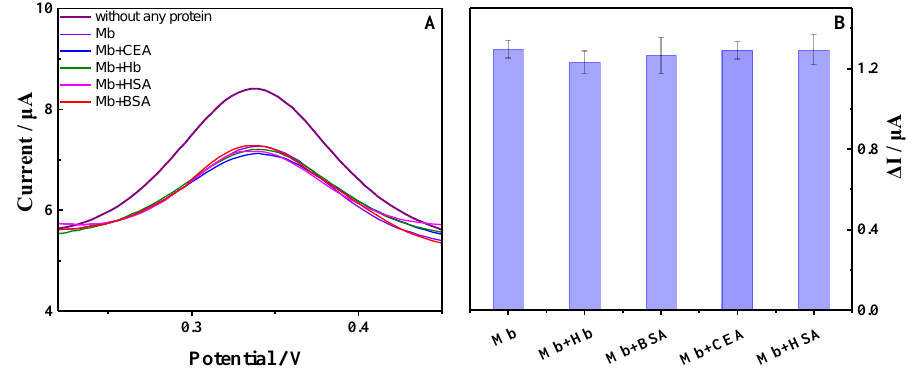
Figure 7. ( A ) DPVs of the aptasensor proposed in the absence and presence of unspecific proteins; ( B ) Specificity of the aptasensor for myoglobin detection. Error bars show the standard deviations of measurements taken from three times (Amplitude: 50 mV, pulse width: 0.050 s).